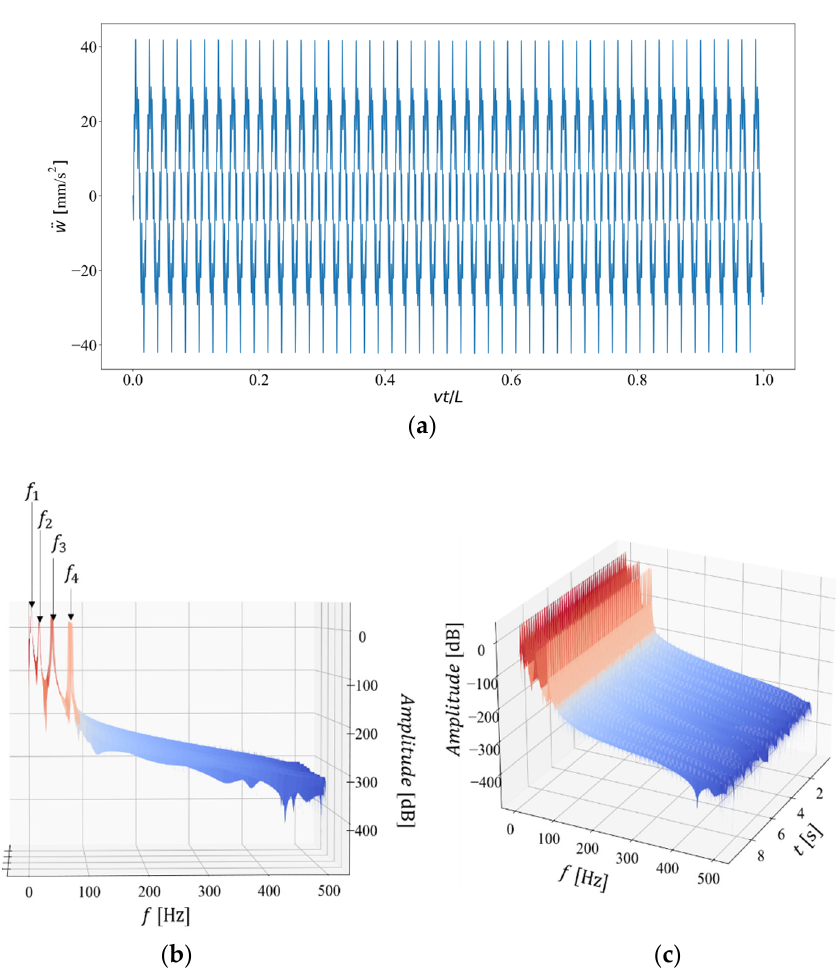
Figure 5. Simply-supported, uncracked beam traversed by a point force P with constant velocity v : ( a ) Acceleration time history w (mm/s 2 ) at station L 1 = 2.00 m, ( b ) Fourier transformed acceleration amplitude W (dB) showing the first four eigenfrequencies fi (Hz) and ( c ) Time-frequency spectrum of the acceleration amplitude W (dB). Note that colors indicate energy intensity in the signal.